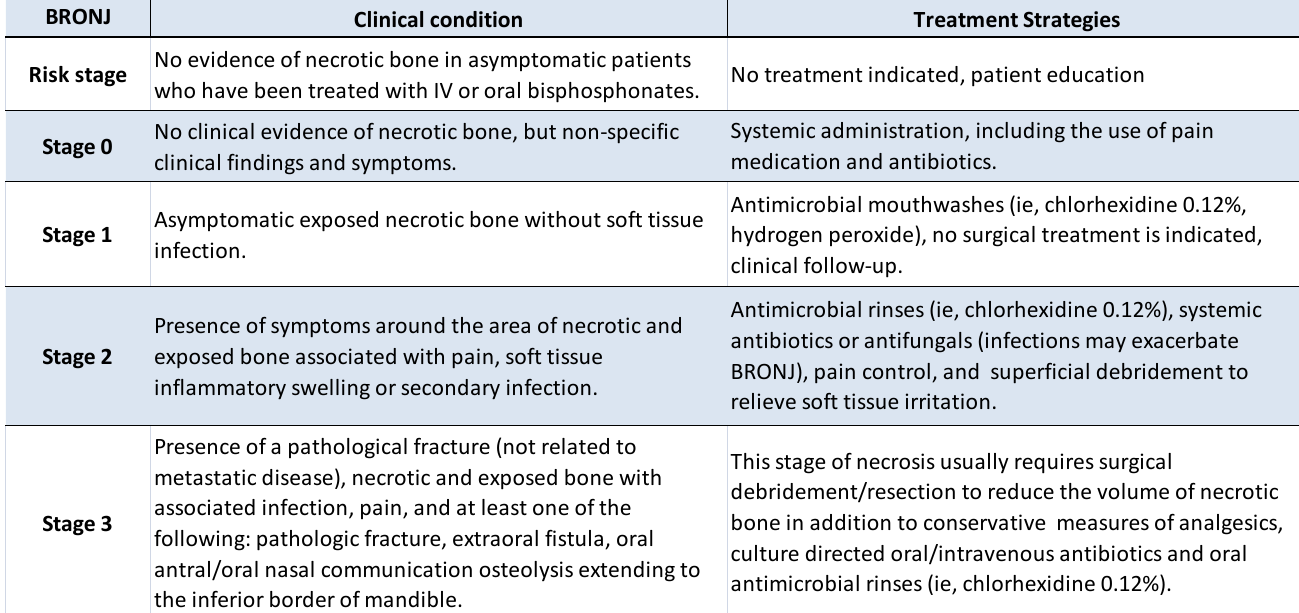
Table 1. Staging and treatment